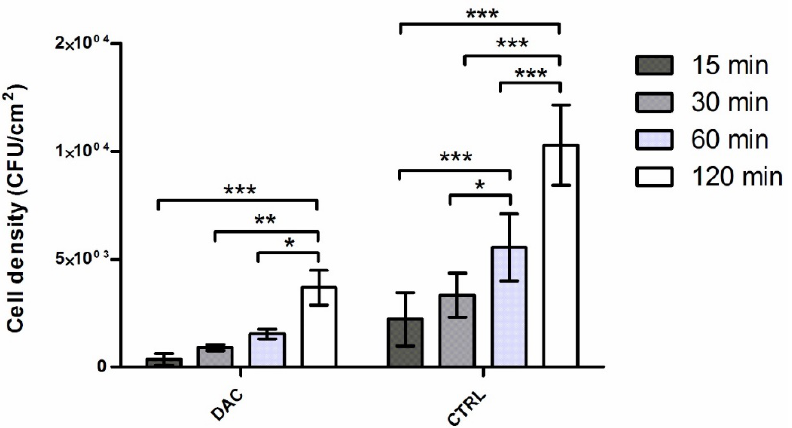
Figure 5. Adhesion densities over time on discs with of S. aureus ( mean CFU/cm 2 ± standard deviation ) applied before DAC treatment and controls at 15, 30, 60, 120 min; * 0.01 < P <0.05, ** 0.001 < P < 0.01, *** P < 0.001 (two-way ANOVA followed by Bonferroni post hoc